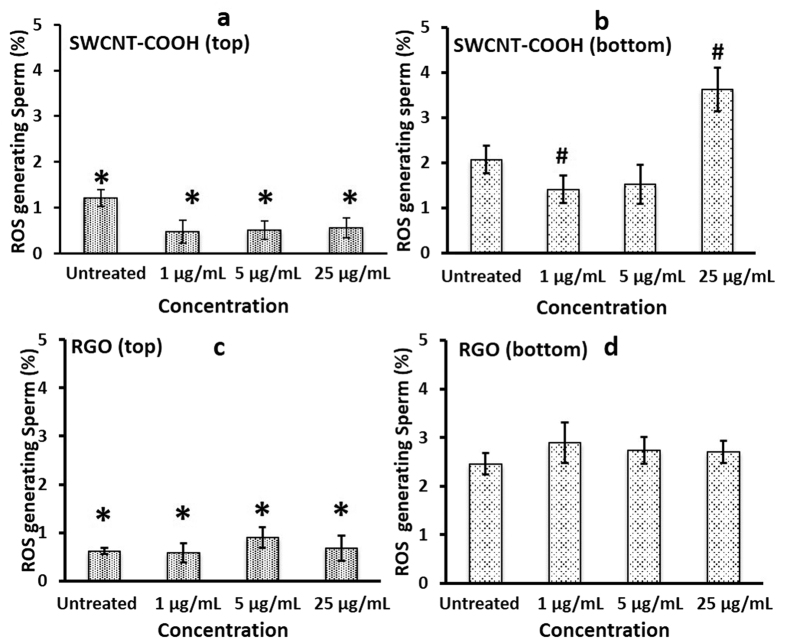
ROS generation sperm population after sorting.Sperm population generating reactive oxide species (ROS) for (a) sorted sperm collected from top chamber (n = 6, Modified Z-Scores method was used to detect outliers in the data69. One data point out of 6 readings has Z-Score > 3.5, therefore it is neglected) and (b) sperm collected from bottom chamber of microfluidic device after samples are incubated with SWCNT-COOH (n = 6). Sperm population generating reactive oxide species (ROS) for (c) sorted sperm collected from top chamber (n = 6) and (d) sperm collected from bottom chamber of microfluidic device after samples are incubated with RGO (n = 6). *p value < 0.05 between sperm collected from top and bottom of the filter. #p value < 0.05 between sperm samples treated with SWCNT-COOH and untreated sample.